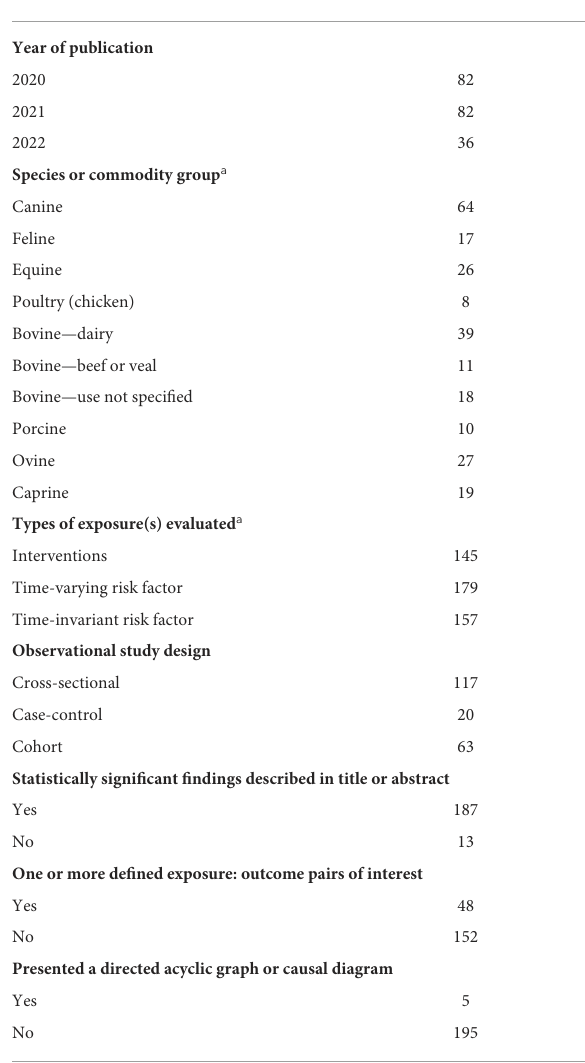
TABLE 2 Descriptive characteristics of 200 observational studies in veterinary species published between 2000 and March 31, 2022, used in an evaluation of the use of causal